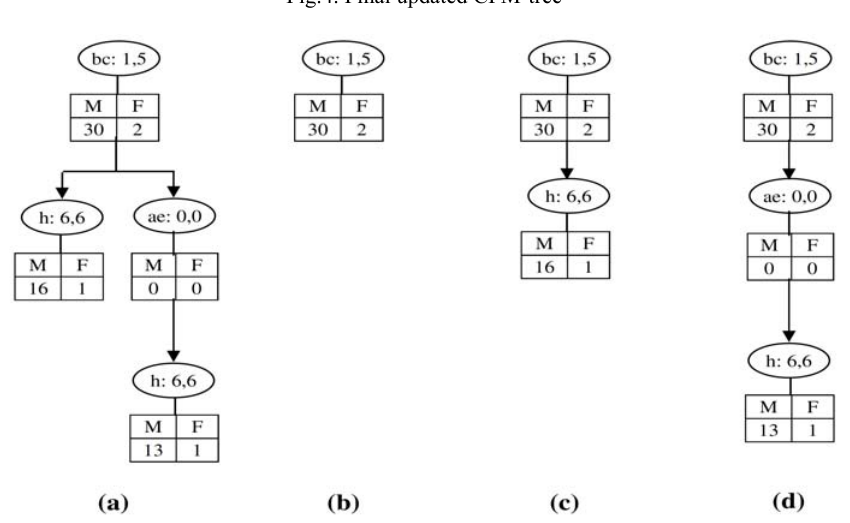
Fig.5. Mining of progressive CFM Patterns from the Updated